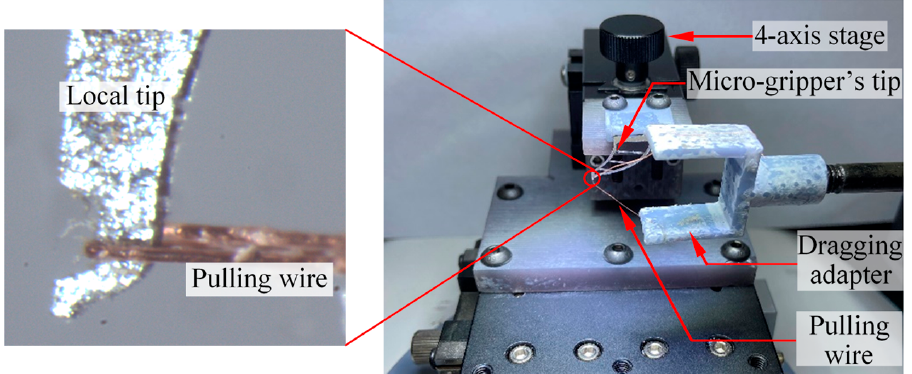
Figure 16. Setup of stiffness measurement system for micro-gripper’s tip. Figure 17a–e are images of the tip-envelope region captured under different tension conditions. In the image, the deformation L 0 – L 6 of the tip-envelope region is measured with a fixed position as the reference point. In the process of measurement, the micro vision system is calibrated, and the space distance of a single pixel in the image is 1.72 μ m.